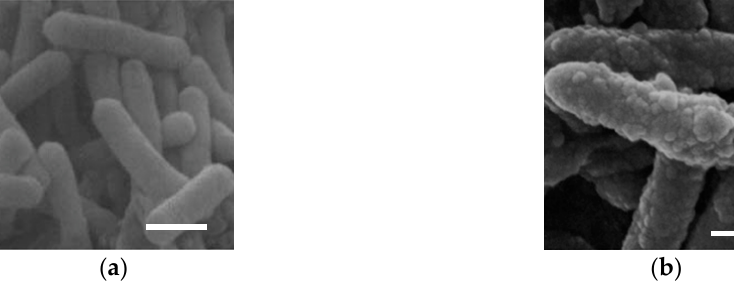
Figure 1. ( a ) Cell surface of C. cellulovorans grown with cellobiose and ( b ) cell surface of C. cellulovorans grown with cellulose. White bar indicates 2 µ m. Modified from [21].